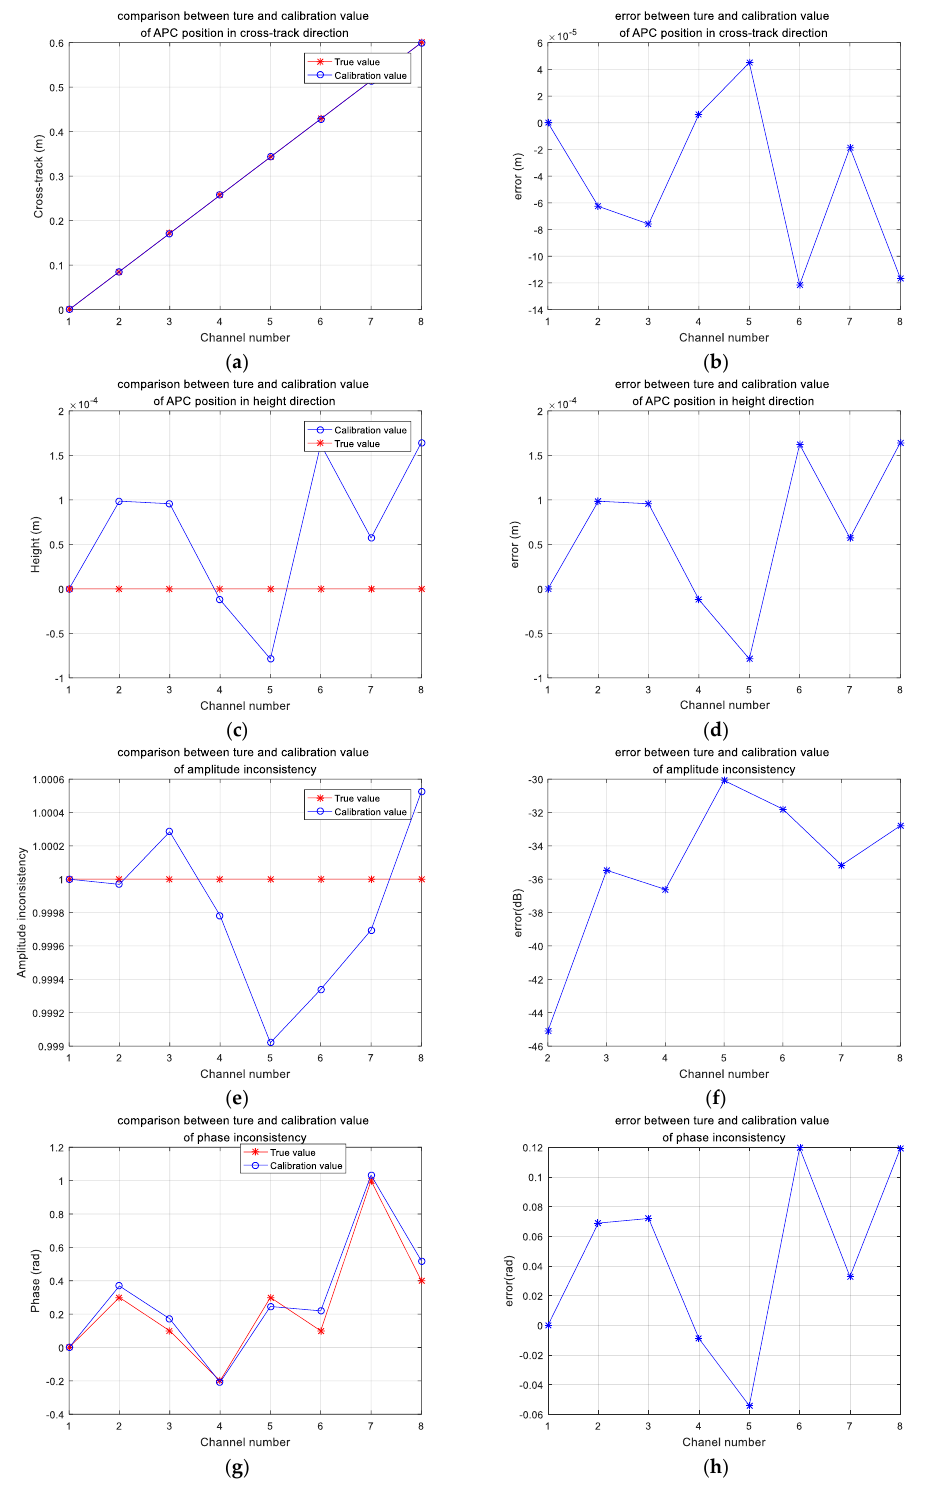
Figure 5. Calibration results of the simulation SAR data set. ( a ) The true and calibration values of axis x (cross-track direction); ( b ) The error between the true and calibration values of axis x ; ( c ) The true and calibration values of axis z (height direction); ( d ) The error between the true and calibration values of axis z ; ( e ) The true and calibration values of the amplitude; ( f ) The error between the true and calibration values of the amplitude; ( g ) The true and calibration values of the phase; ( h ) The error between the true and calibration values of the